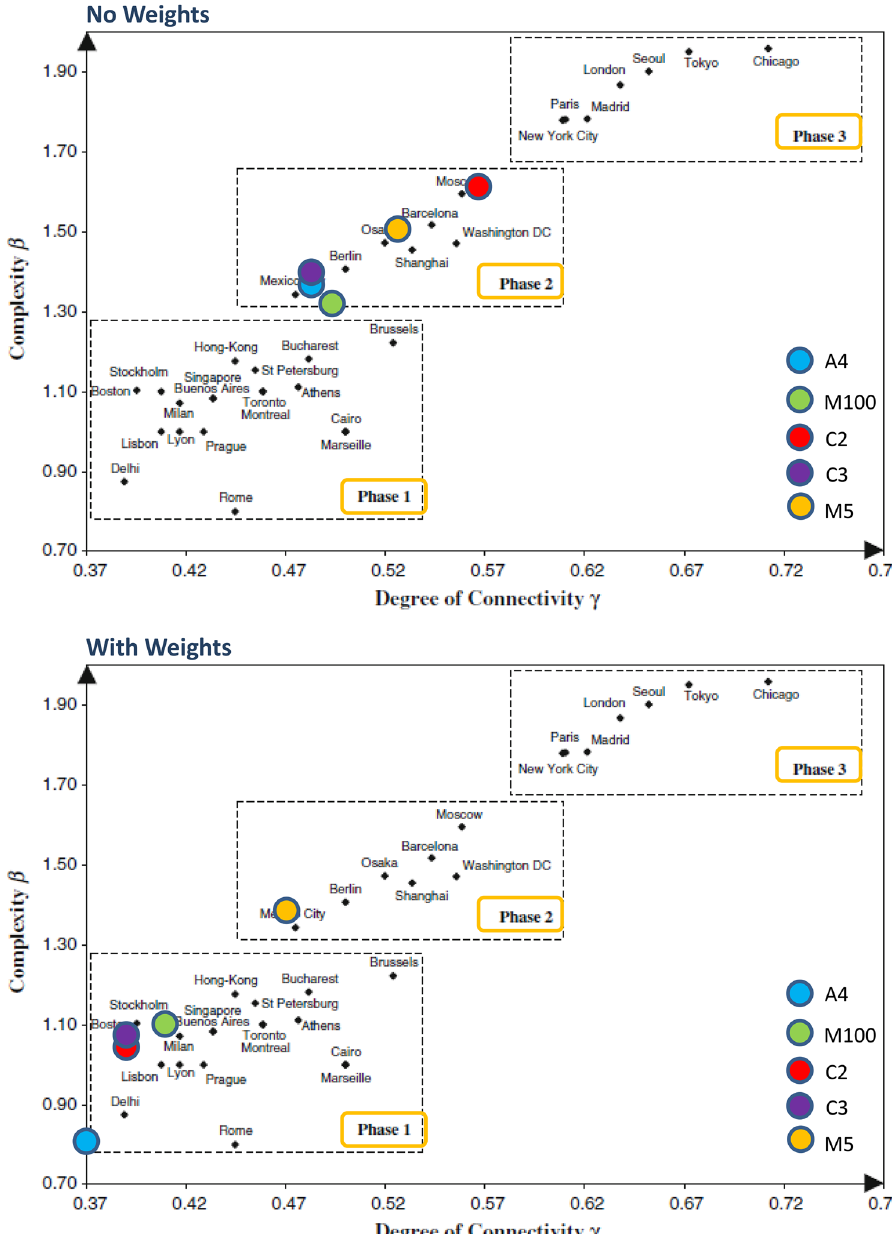
Fig. 1 Network development (state). Note The TA network alternatives are presented on top of original graph